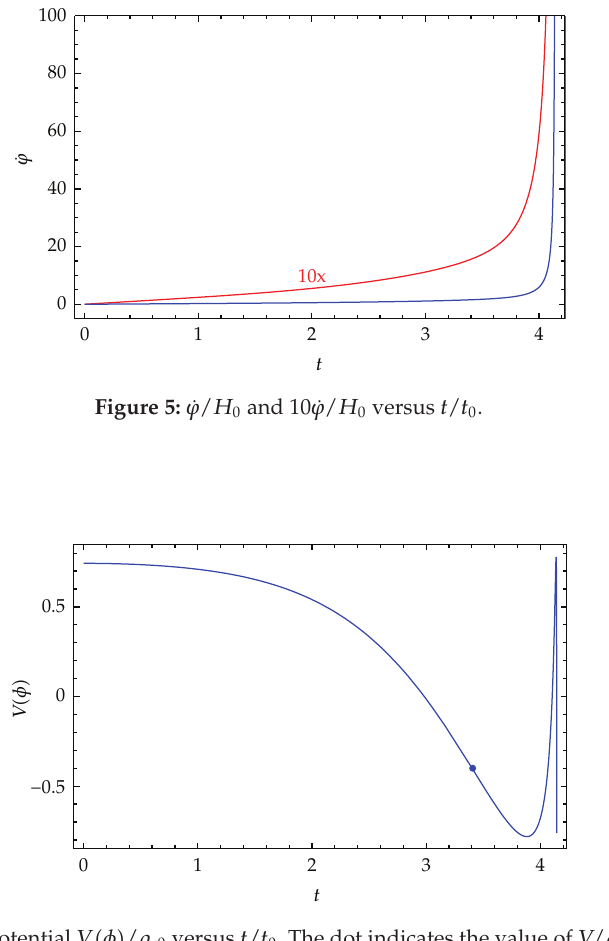
Figure 6: Potential V (cid:2) φ (cid:3) /ρ c 0 versus t/t 0 . The dot indicates the value of V/ρ c 0 at t ∗ .